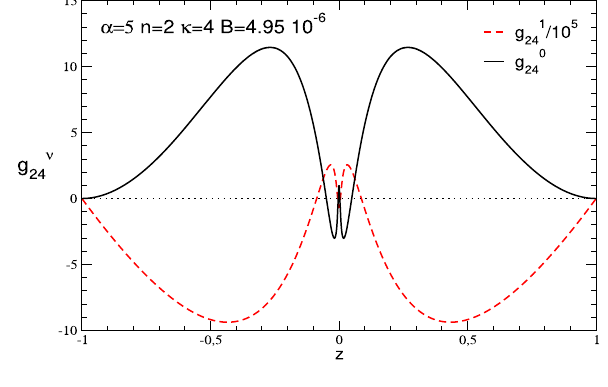
Fig. 9 g ν from state No. 6 in Table 2 24